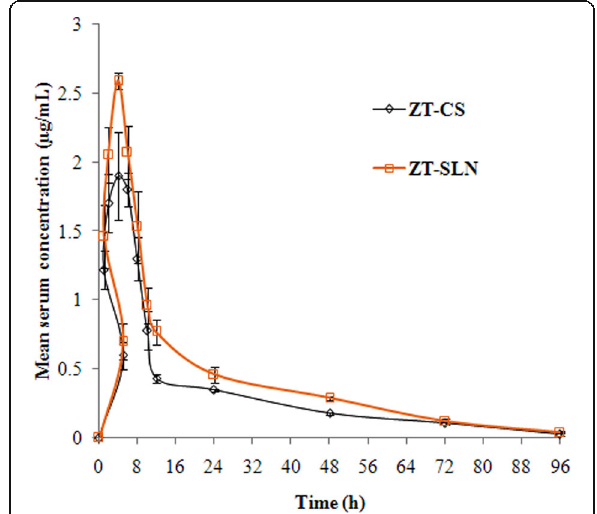
Fig. 6 Mean serum concentration — time profiles of zotepine from